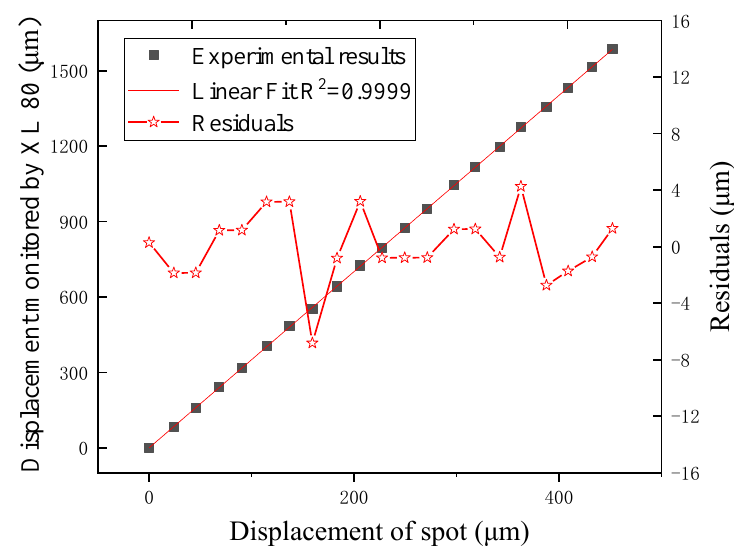
Figure 8. Calibration results in the X direction.